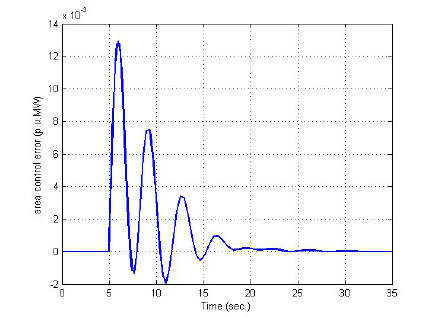
Fig. 5: ACE in control area 1 (Case 1)